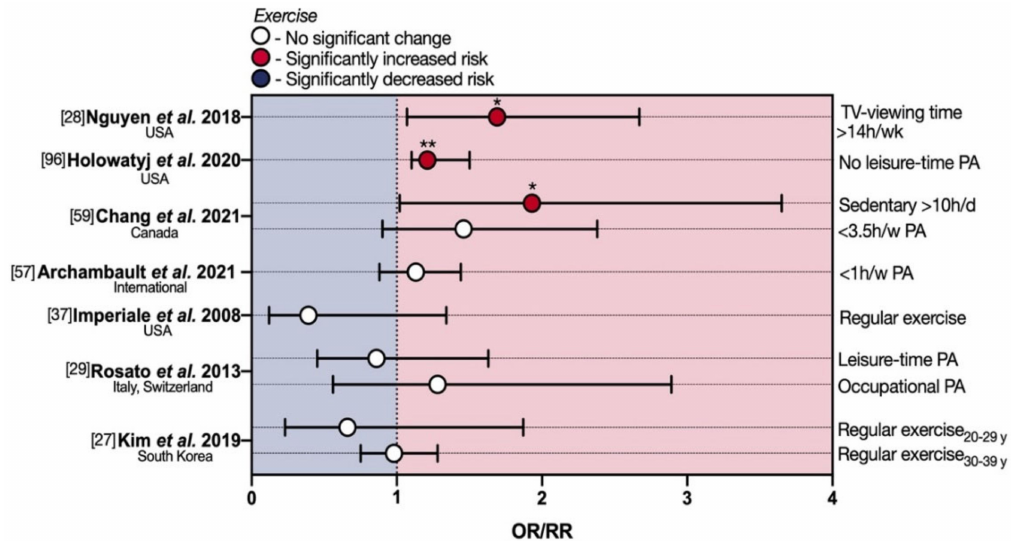
Figure 4. Protective and deleterious effects of physical activity in early-onset colorectal cancer. eoCRC—early-onset colorectal cancer; OR—odds ratio; PA—physical activity; RR—relative risk. * p < 0.05; ** p <